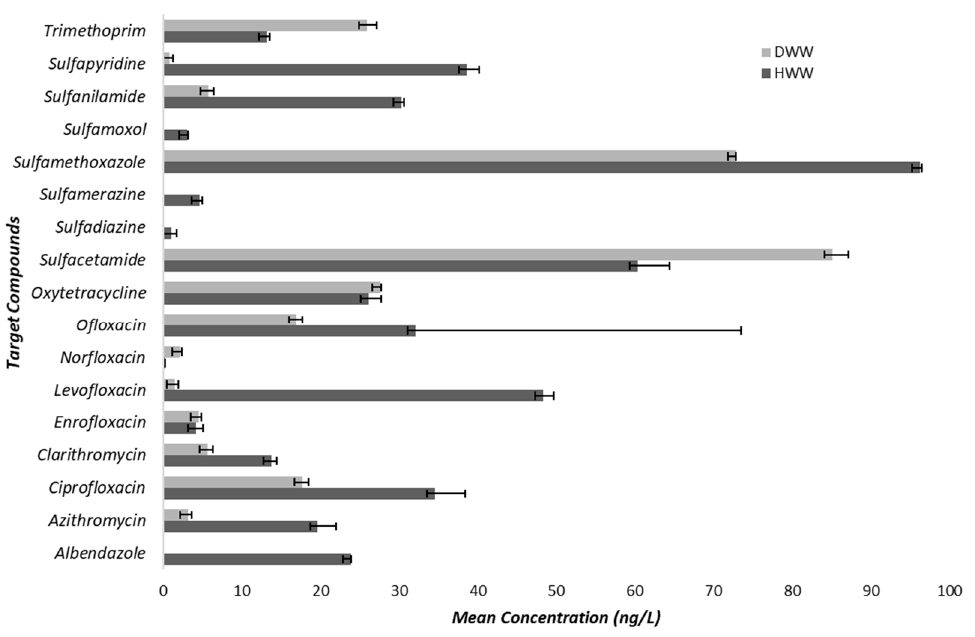
Figure 1. Mean concentration of targeted antibiotic compounds in hospital and domestic wastewater samples. Error bars indicate the 95% confidence intervals.